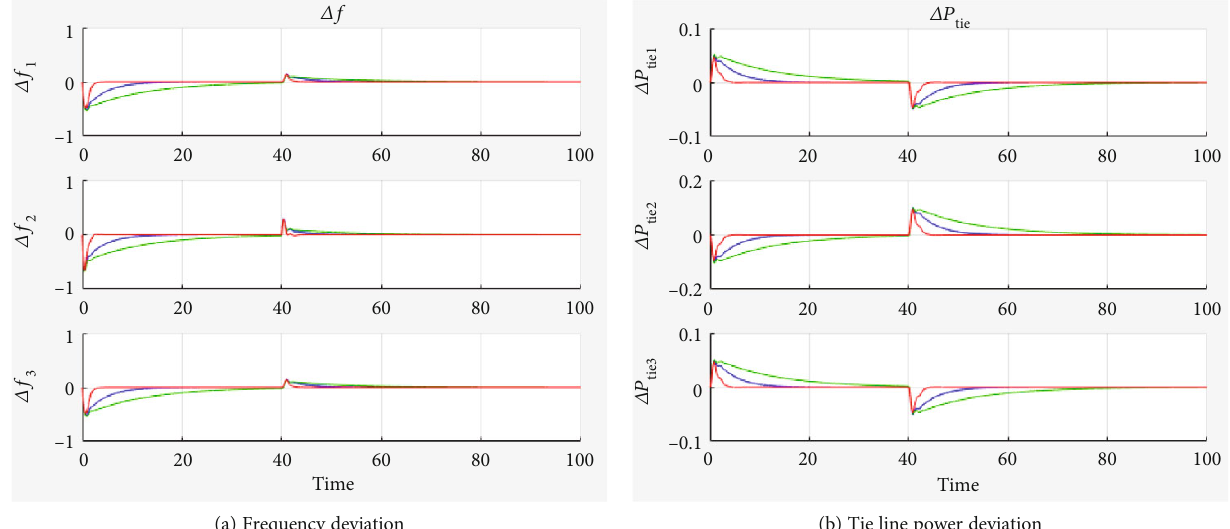
Figure 12: Response of the system under sudden load change from 0.4 to 0.2 p.u in area 2 at 40